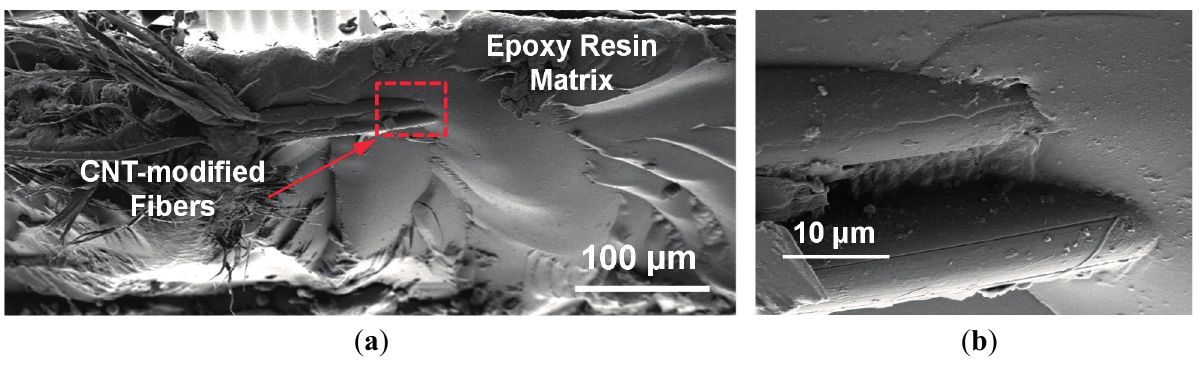
Figure 6. SEM image showing ( a ) fracture surface of nanocomposite sensor fabricated in this study and ( b ) a high-magnification image showing the CNT-modified fibers (dashed area in